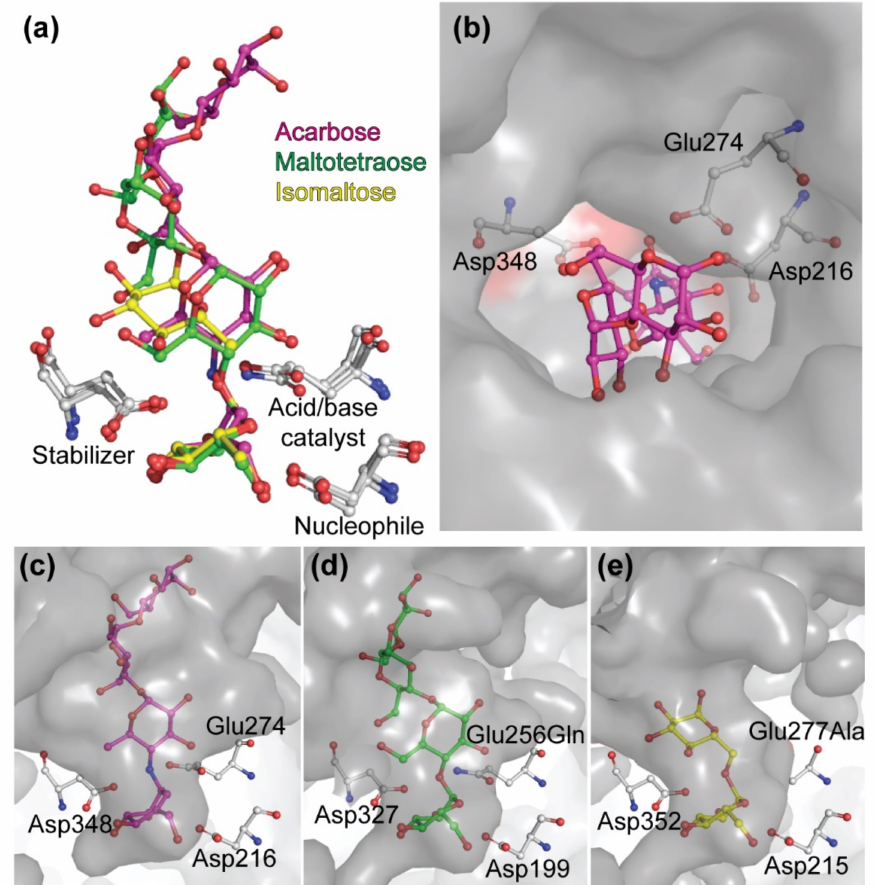
Figure 6. Substrate binding pocket of selected GH13 enzymes. Superimposed conformations of acarbose, maltotetraose and isomaltose ( a ). Top view of substrate binding cavity of the maltase Ba AG2 of B. adeninivorans with bound acarbose (magenta) ( b ). Side views of substrate binding modes of acarbose (panel c , magenta) to Ba AG2, maltotetraose (panel d , green) to BspAG13_31 mutant Glu256Gln of Bacillus sp . AHU2216 (PDB: 5ZCE) and isomaltose (panel e , yellow) to IMA1 mutant Glu277Ala of S. cerevisiae (PDB: 3AXH). Catalytic triad amino acids are marked by grey sticks. Structures were aligned and visualized with PyMol